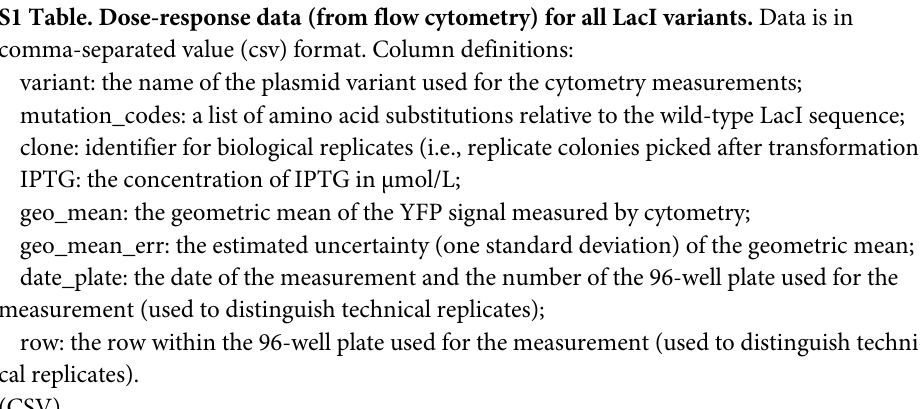
S1 Table. Dose-response data (from flow cytometry) for all LacI variants. Data is in